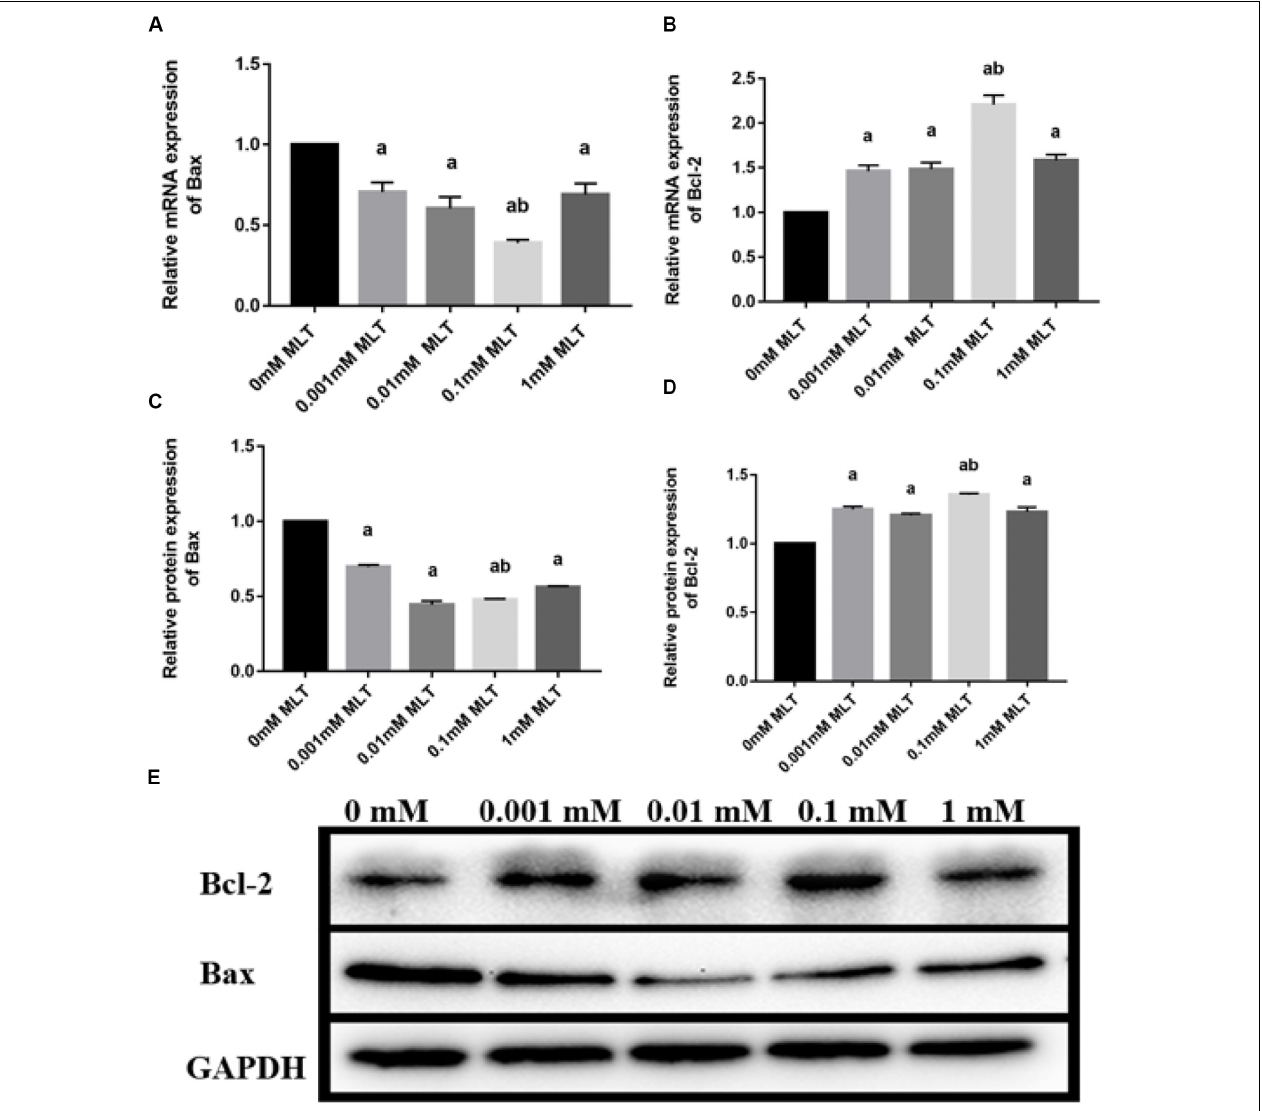
FIGURE 3 | Effect of MLT on mRNA and protein expressions of Bax and Bcl-2 in cryopreserved OTs. (A) Relative mRNA expressions of Bax in each MLT-(un)treated group. (B) Relative mRNA expressions of Bcl-2 in each MLT-(un)treated group. (C) Protein expressions of Bax in each MLT-(un)treated group. (D) Protein expressions of Bcl-2 in each MLT-(un)treated group. (E) Representative Western blot image of Bax and Bcl-2 in each MLT-(un)treated group. Data are shown as the mean ± SEM. a P < 0.05 compared with the 0-mM MLT-untreated group; b P < 0.05 compared with the MLT-treated